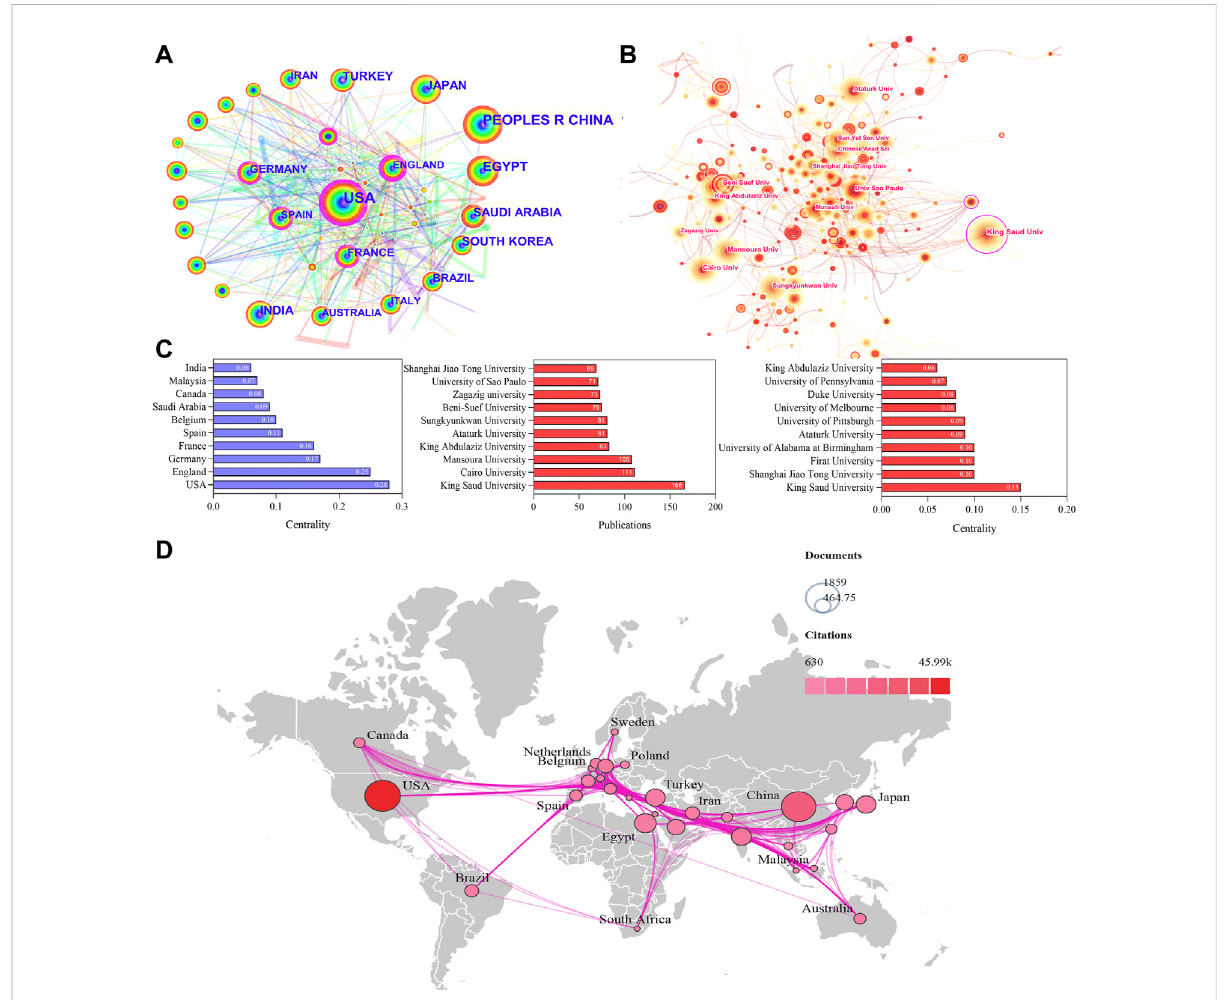
FIGURE 3 Visualizationmapofcountries/regionsandinstitutionsinvolvedinnephrotoxicityresearch. (A) CollaborationnetworkofcountriesofCiteSpace. N = 123, E = 552. (B) Collaboration network of institutions of CiteSpace. N = 520, E = 978. ( N represents the number of network nodes and E represents the number of connections). (C) Publications and centrality of countries/regions and institutions in nephrotoxicity research. (D) Collaborative relationships in